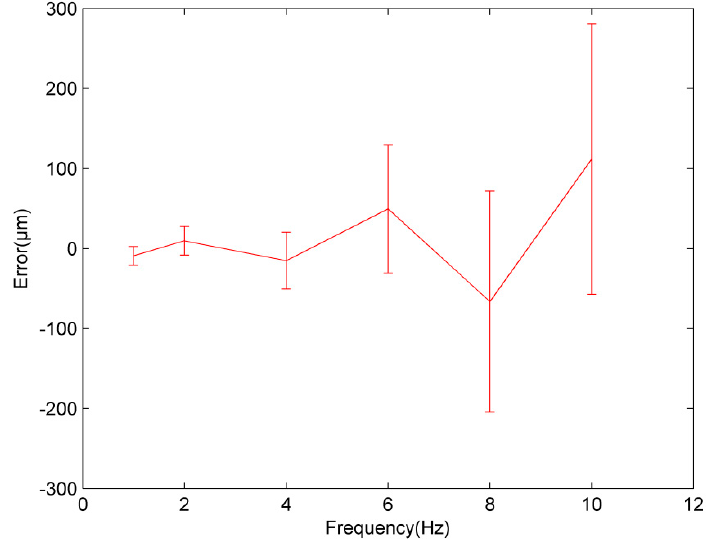
Figure 6. Error and standard deviation at different vibration frequencies (after the vibration compensation).